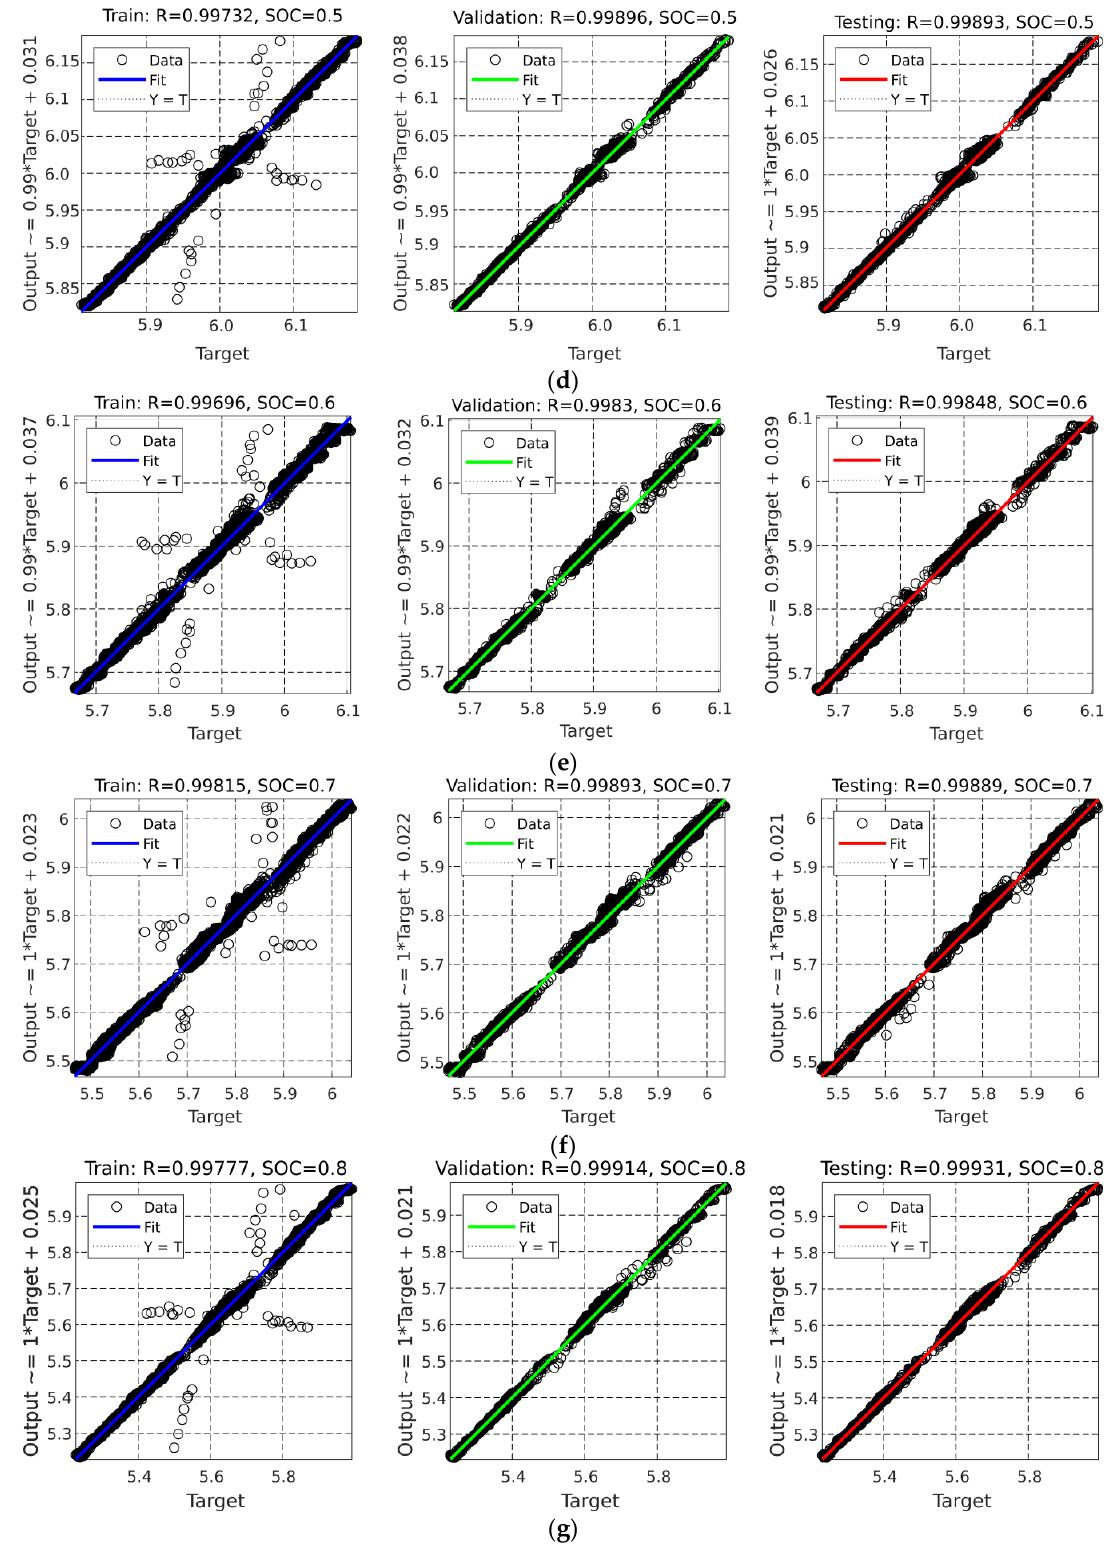
Figure 8. The linear regression plots of NARX-ANN model for training, validation and testing subsets, ( a ) SOC = 0.2; ( b ) SOC = 0.3; ( c ) SOC = 0.4; ( d ) SOC = 0.5; ( e ) SOC = 0.6; ( f ) SOC = 0.7 and ( g ) SOC = 0.8 in pulse work cycle.